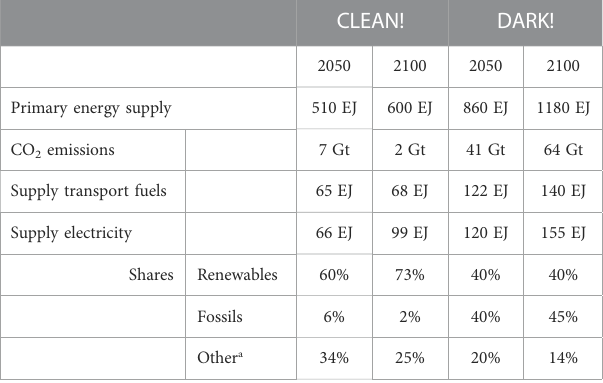
TABLE 3 Global energy and emissions results from ETSAP-TIAM